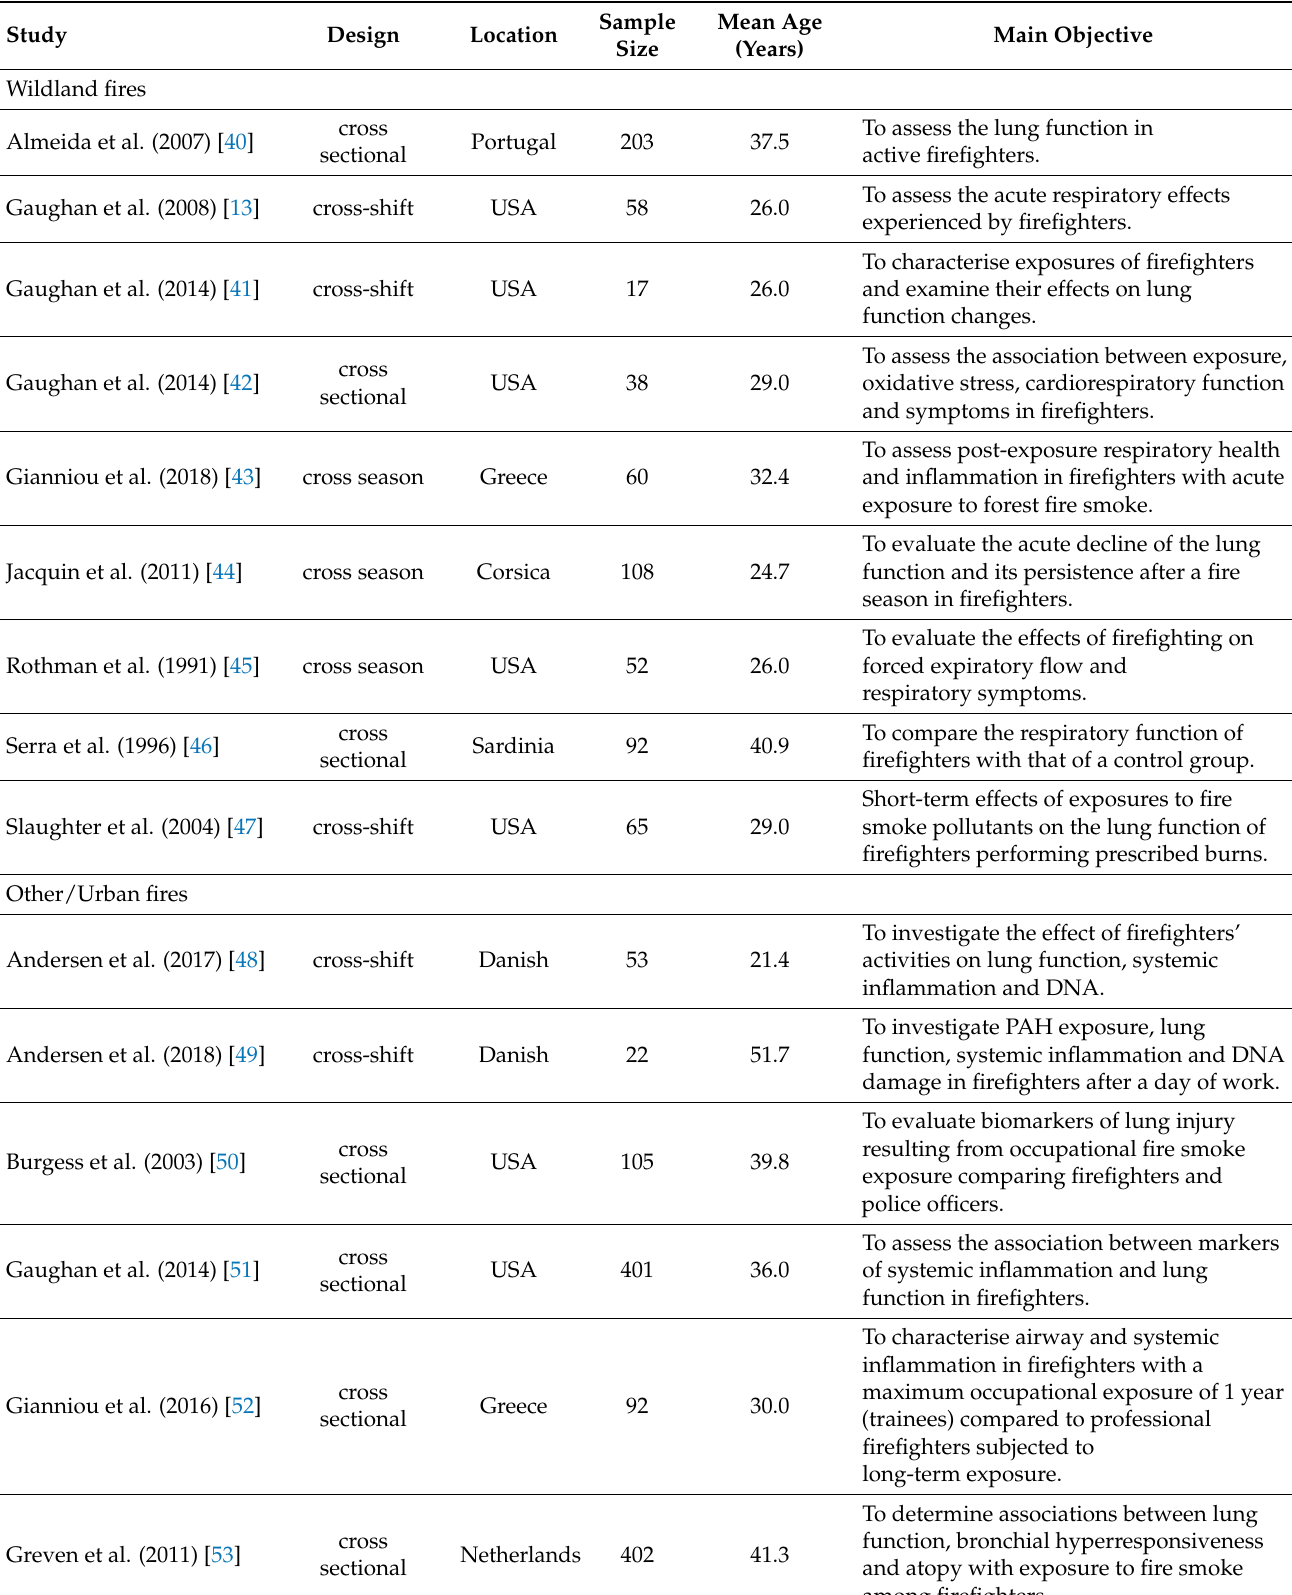
Table 1. Main characteristics of the studies included in the